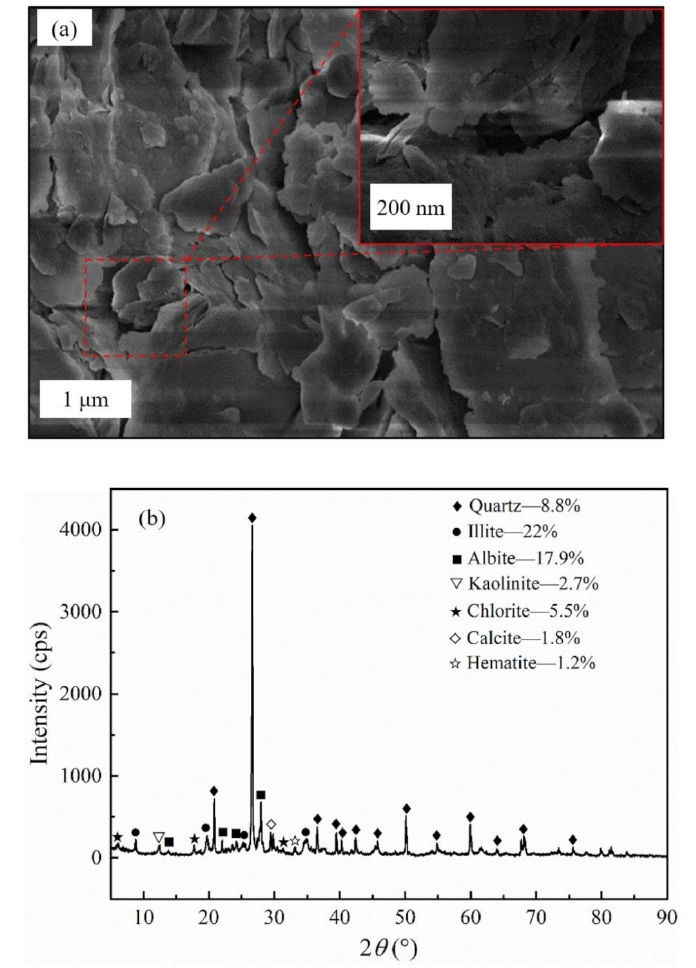
Figure 3. Material properties. ( a ) SEM images of particles surface. The inset focusing on the pore domain. ( b ) Mineral intensity versus 2 θ , obtained from X-ray diffraction of the weathered broken argillaceous